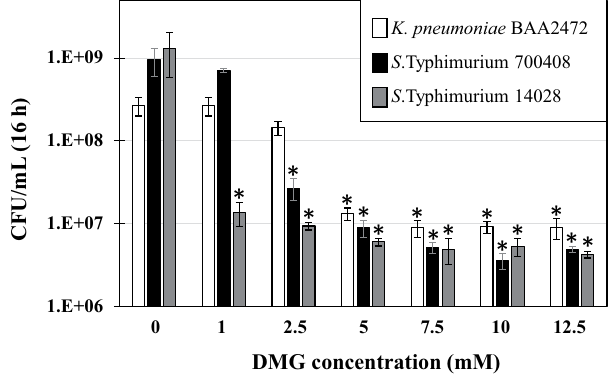
Figure 2. Effect of DMG on the growth of MDR K. pneumoniae and S . Typhimurium strains. K. pneumoniae BAA2472, S . Typhimurium 700408 and S . Typhimurium 14028 were inoculated (approximately 5 × 10 6 CFU/ mL) in appropriate media containing increasing concentrations of DMG, as indicated, and grown at 37 °C under aerobic conditions and constant shaking. Cell growth (CFU/mL) at 16 h was determined by serial dilution and plating. Results shown represent means and standard deviations from three biological replicates. The asterisk above each bar indicates the bacterial growth (CFU/mL) is significantly lower compared to the no (0) DMG control ( P < 0.01, Student’s t -test).